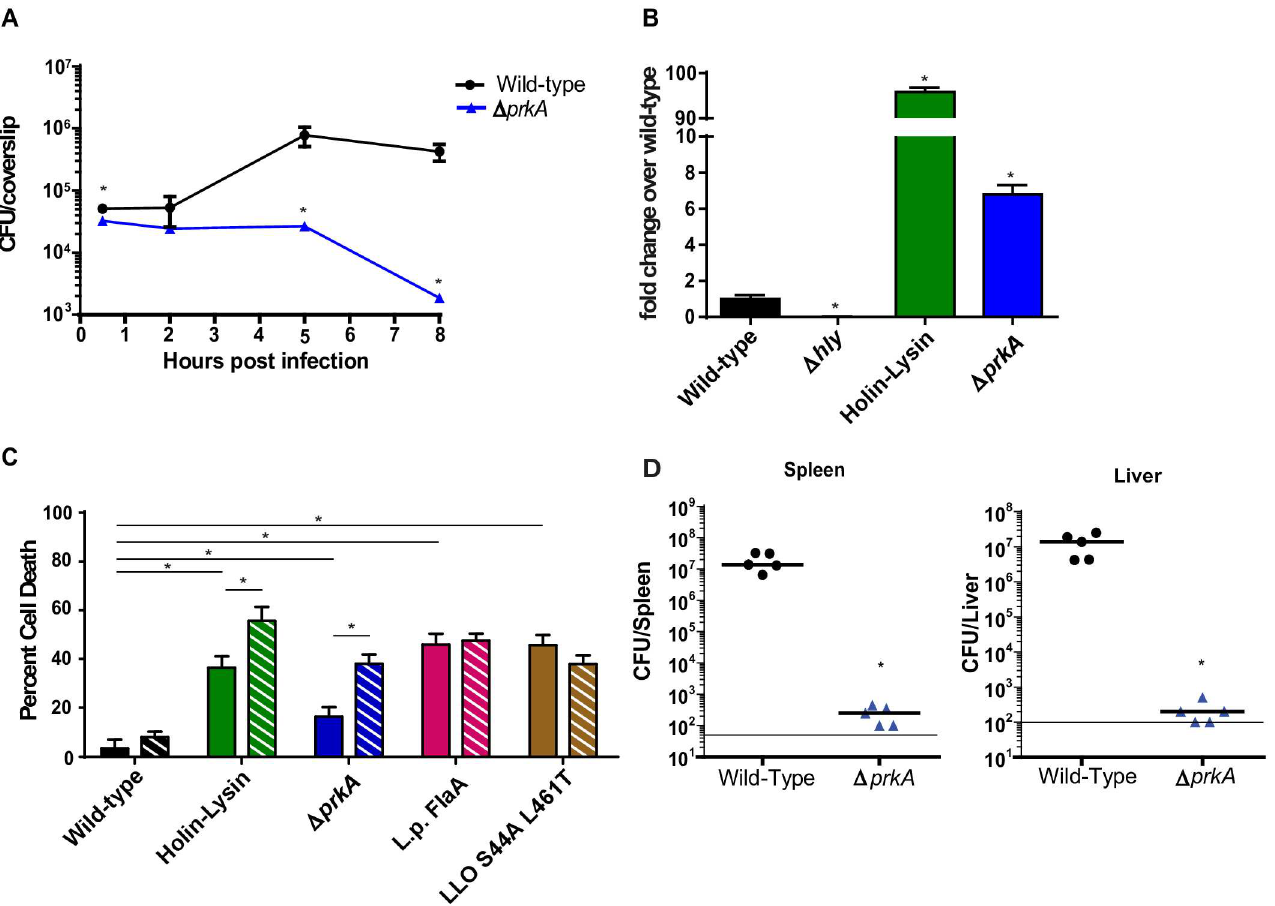
Fig 2. PrkA is required for intracellular replication, cytosolic survival, evasion of inflammasome activation and virulence. (A) Intracellular growth of wild-type (black circles) and Δ prkA mutants (blue triangles)was determinedin bone marrow-derived macrophages (BMDMs) following infection at an MOI of 0.2. (B) Intracellularlysis of L . monocytogenes was measuredin immortalizedinterferon α / β receptor (IFNAR) -/- macrophages. Macrophages were infected at an MOI of 5 by L . monocytogenes strains carrying pBHE573and macrophageluciferaseexpressionwas measured6 hours post infection. (A, B) Mean values are reported. Experiments are representativeof three or more biologicalreplicatesand error bars represent the standard deviationof technical triplicates. * indicates statistical significance by Student’s T-test (P < 0.05). (C) Host Cell Death inducedin wild- type C57/Bl6 (solid) or Gbp Chr3-/- (hashed) BMDMs was analyzedby lactate dehydrogenase release 6 hours post infection at an MOI of 5. Data is an averageof three biologicalreplicatesand error bars represent standard deviation of the mean. * indicates statistical significance by Student’s T-test (P < 0.05). (D) C57Bl6 mice were infected intravenouslywith 1x10 5 wild-type (black circles) or Δ prkA mutants (blue triangles) in vivo . Spleens(left) and Livers (right) were harvested 48 hours post infection homogenized and platedfor CFU. The median (solid bar) and limit of detection (line) for each experimentis indicated.Data are representative of two independent experiments with 5 mice each. * indicatesstatistical significanceby Mann- Whitney Test (P < 0.05).